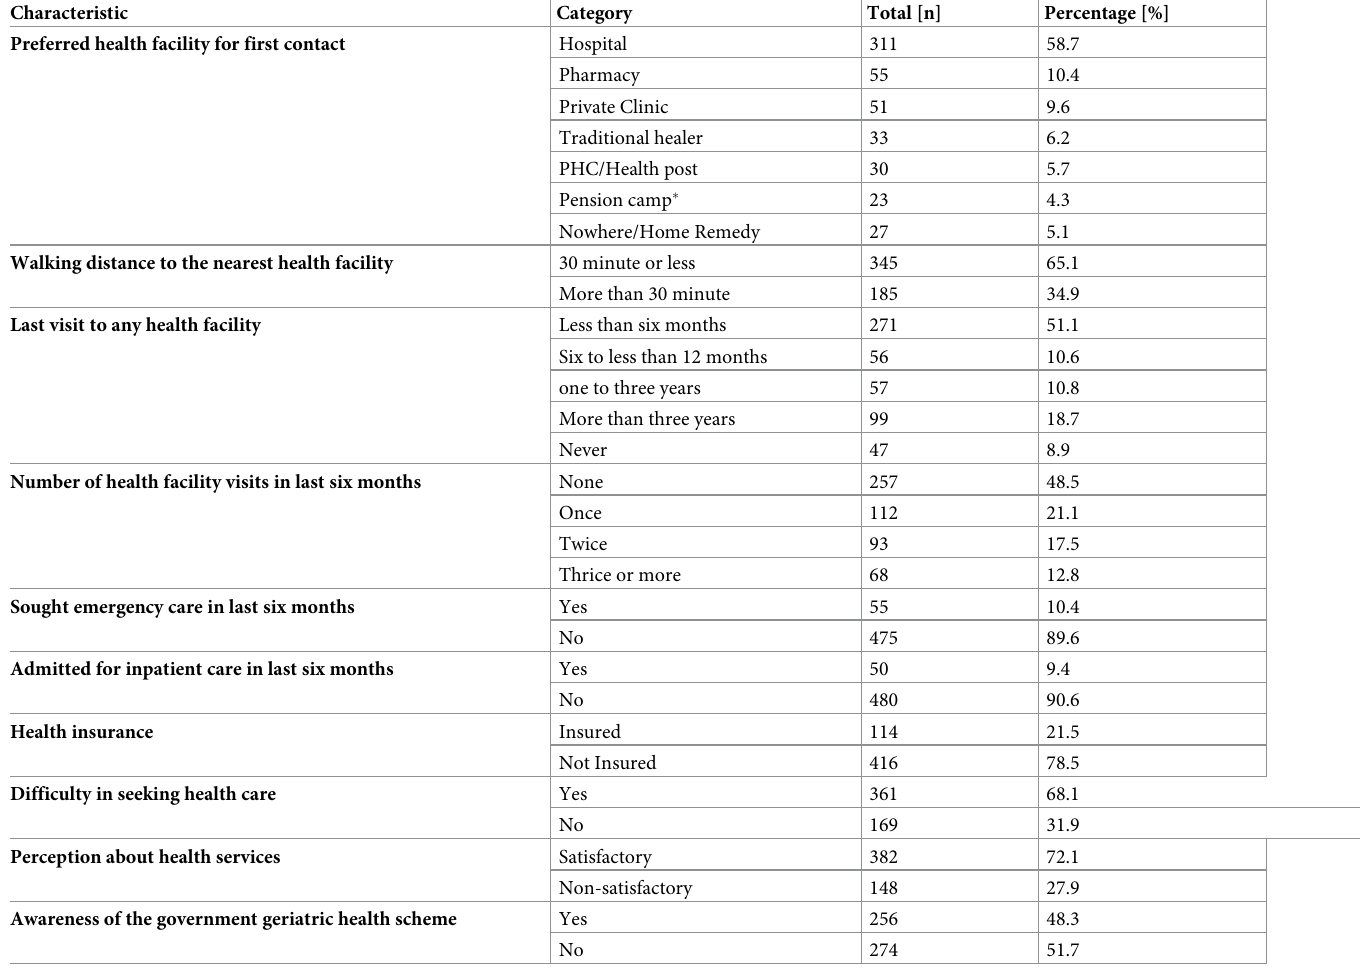
Table 3. Health care seeking and utilization behaviour among the participants [n =